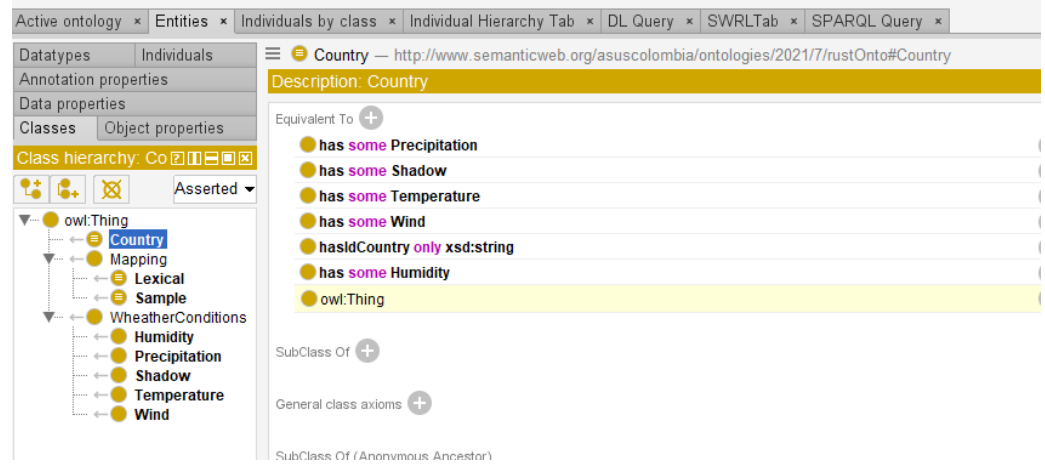
Figure 9. Complete definition for the country class (Protégé editor).